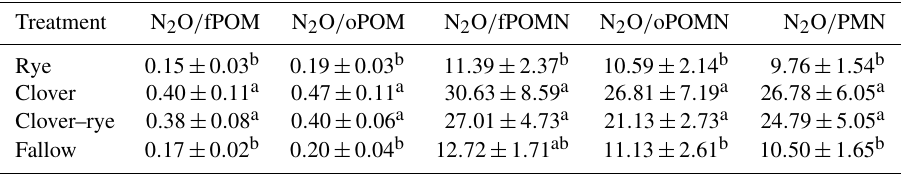
Table 4. Mean ± standard error for ratios of grams of N 2 O per gram of POM and grams of N 2 O per kilogram of PMN averaged across both sites by treatment. Significant treatment differences are indicated by different letters.